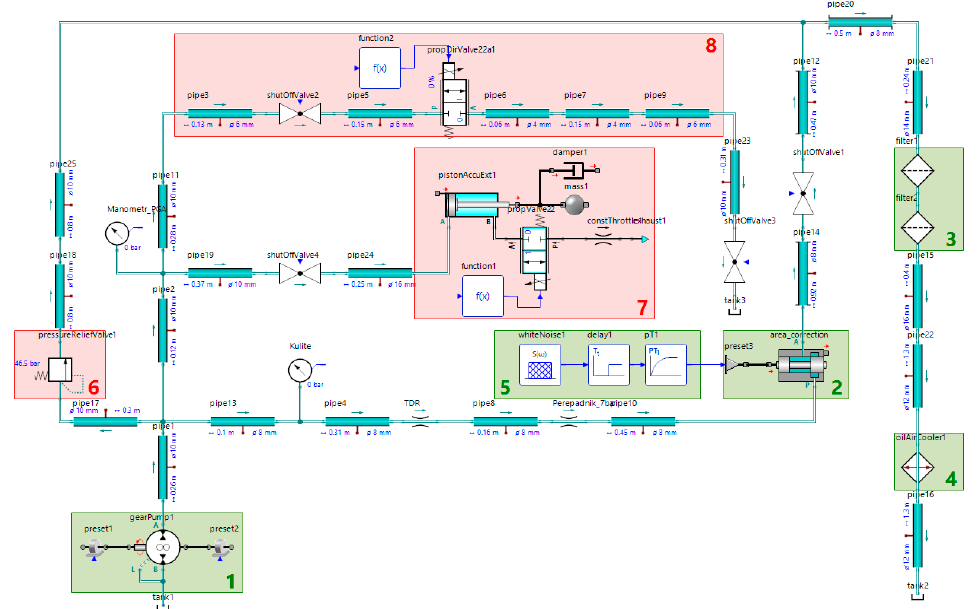
Figure 4. The SimulationX model of our fluid power supply system with built-in faults: 1—the